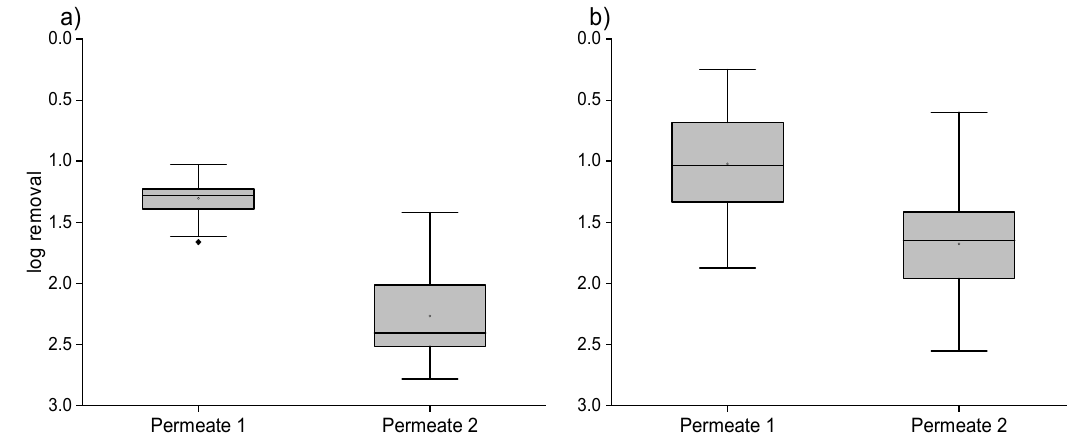
Figure 8. Differences in log removal rates of Permeate 1 and Permeate 2 in ( a ) flocculated Elbe river water t-test, n = 59, p < 0.05, n = 59 and ( b ) Elbe River water, t-test, n = 44, p < 0.05.